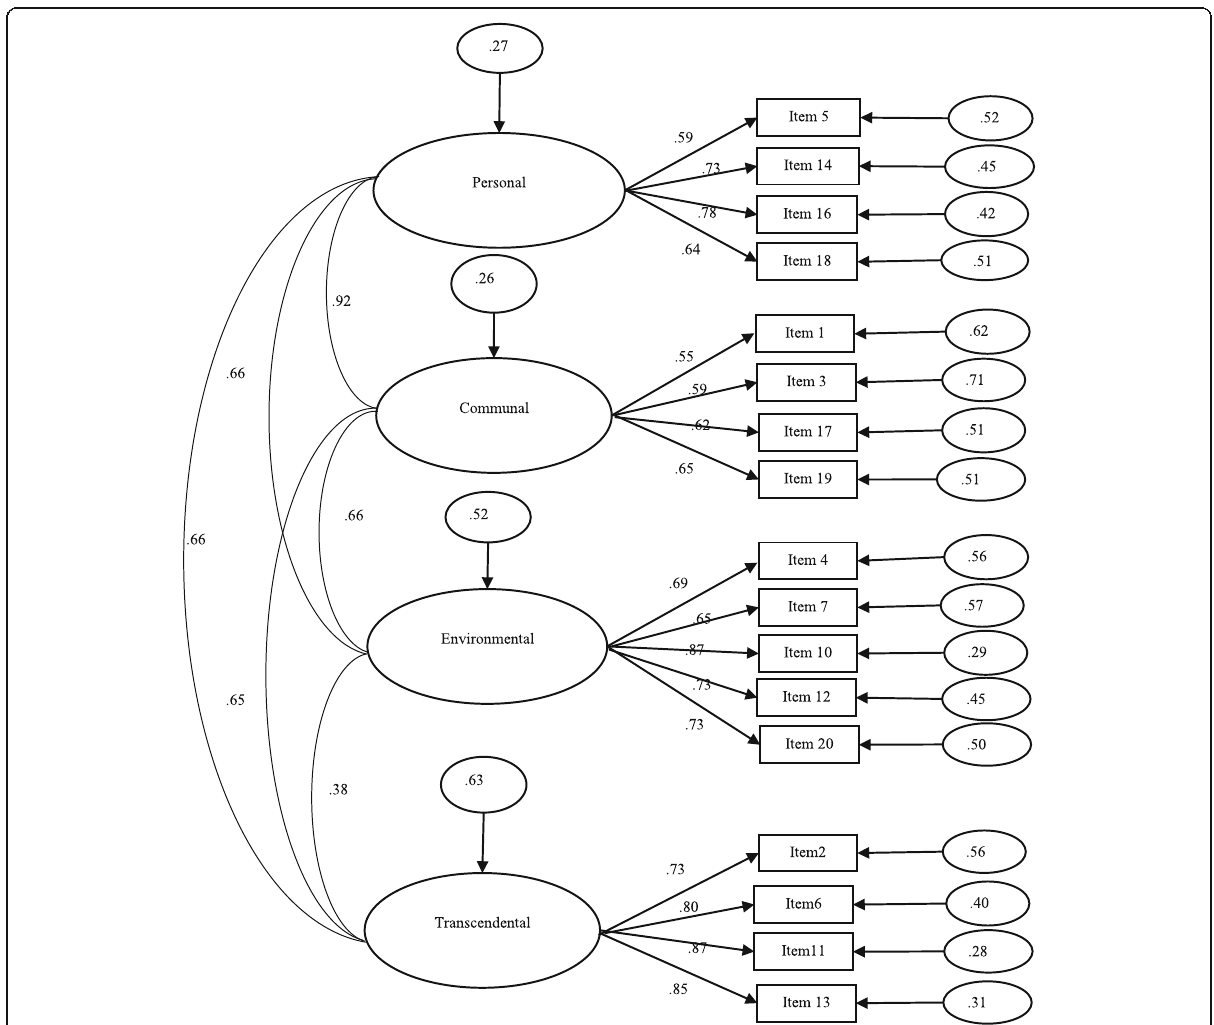
Fig. 1 Measurement model with 17 items and four factors, confirmed in the validation sample. All saturation values are significant ( p <